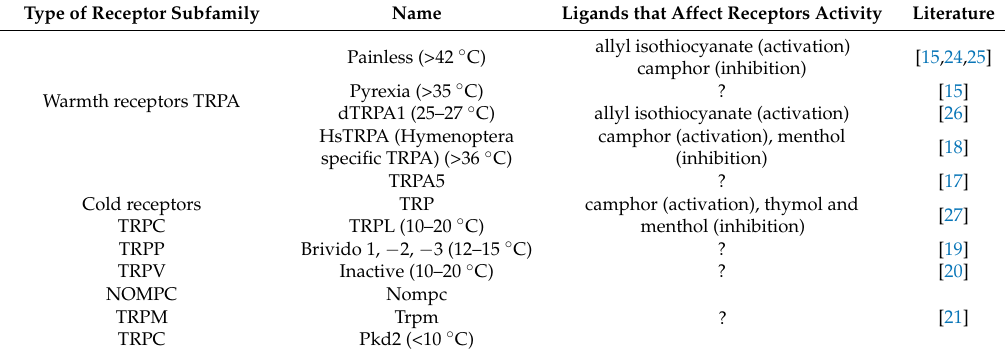
Table 1. Insect thermo-TRP and their chemical agonists or antagonists.